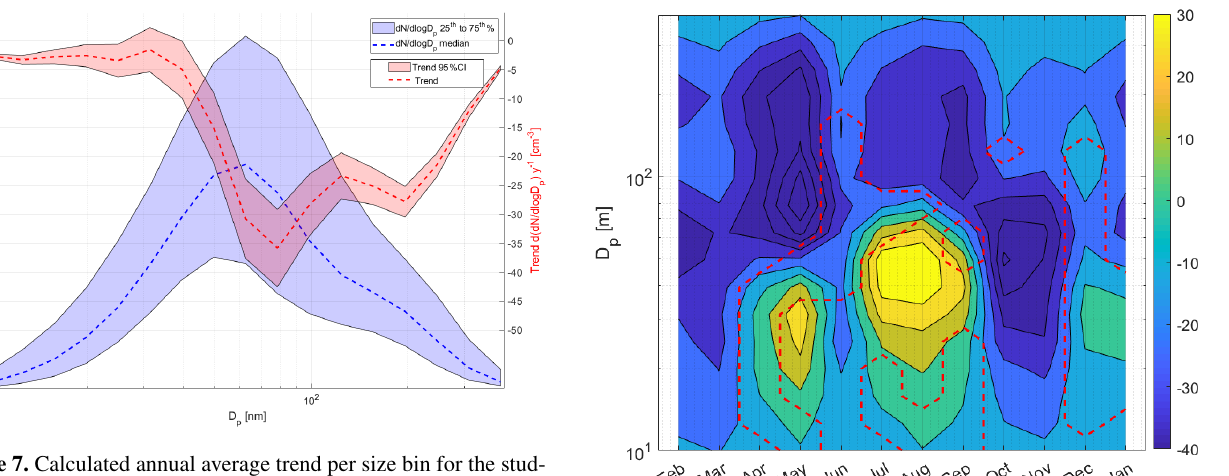
Figure 7. Calculated annual average trend per size bin for the stud- ied period 2000–2017 (right y axis). The figure also shows median number size distribution and 25th–75th percentile interval for refer- ence (left y axis). Figure 8. Contour plot depicting the calculated trends (as Theil–Sen